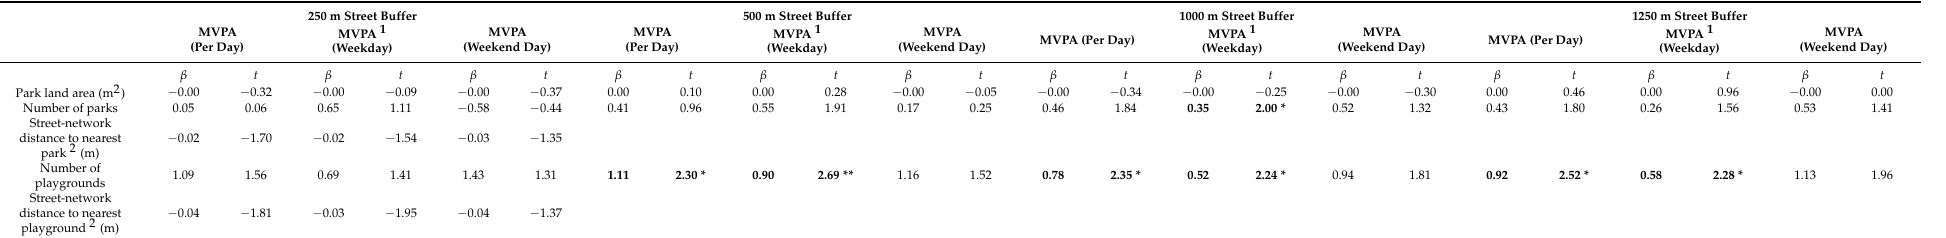
Table 3. Mixed-model regression results for the relationship between the availability and proximity to parks and playgrounds in the participants’ neighborhood and moderate–vigorous physical activity (MVPA).